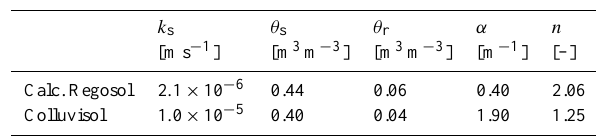
Table 1. Laboratory measurements of average hydraulic proper- ties for typical Weiherbach soils (after van Genuchten, 1980, and Mualem, 1976): saturated hydraulic conductivity k s , porosity θ s , residual water content θ r , air entry value α , shape parameter n